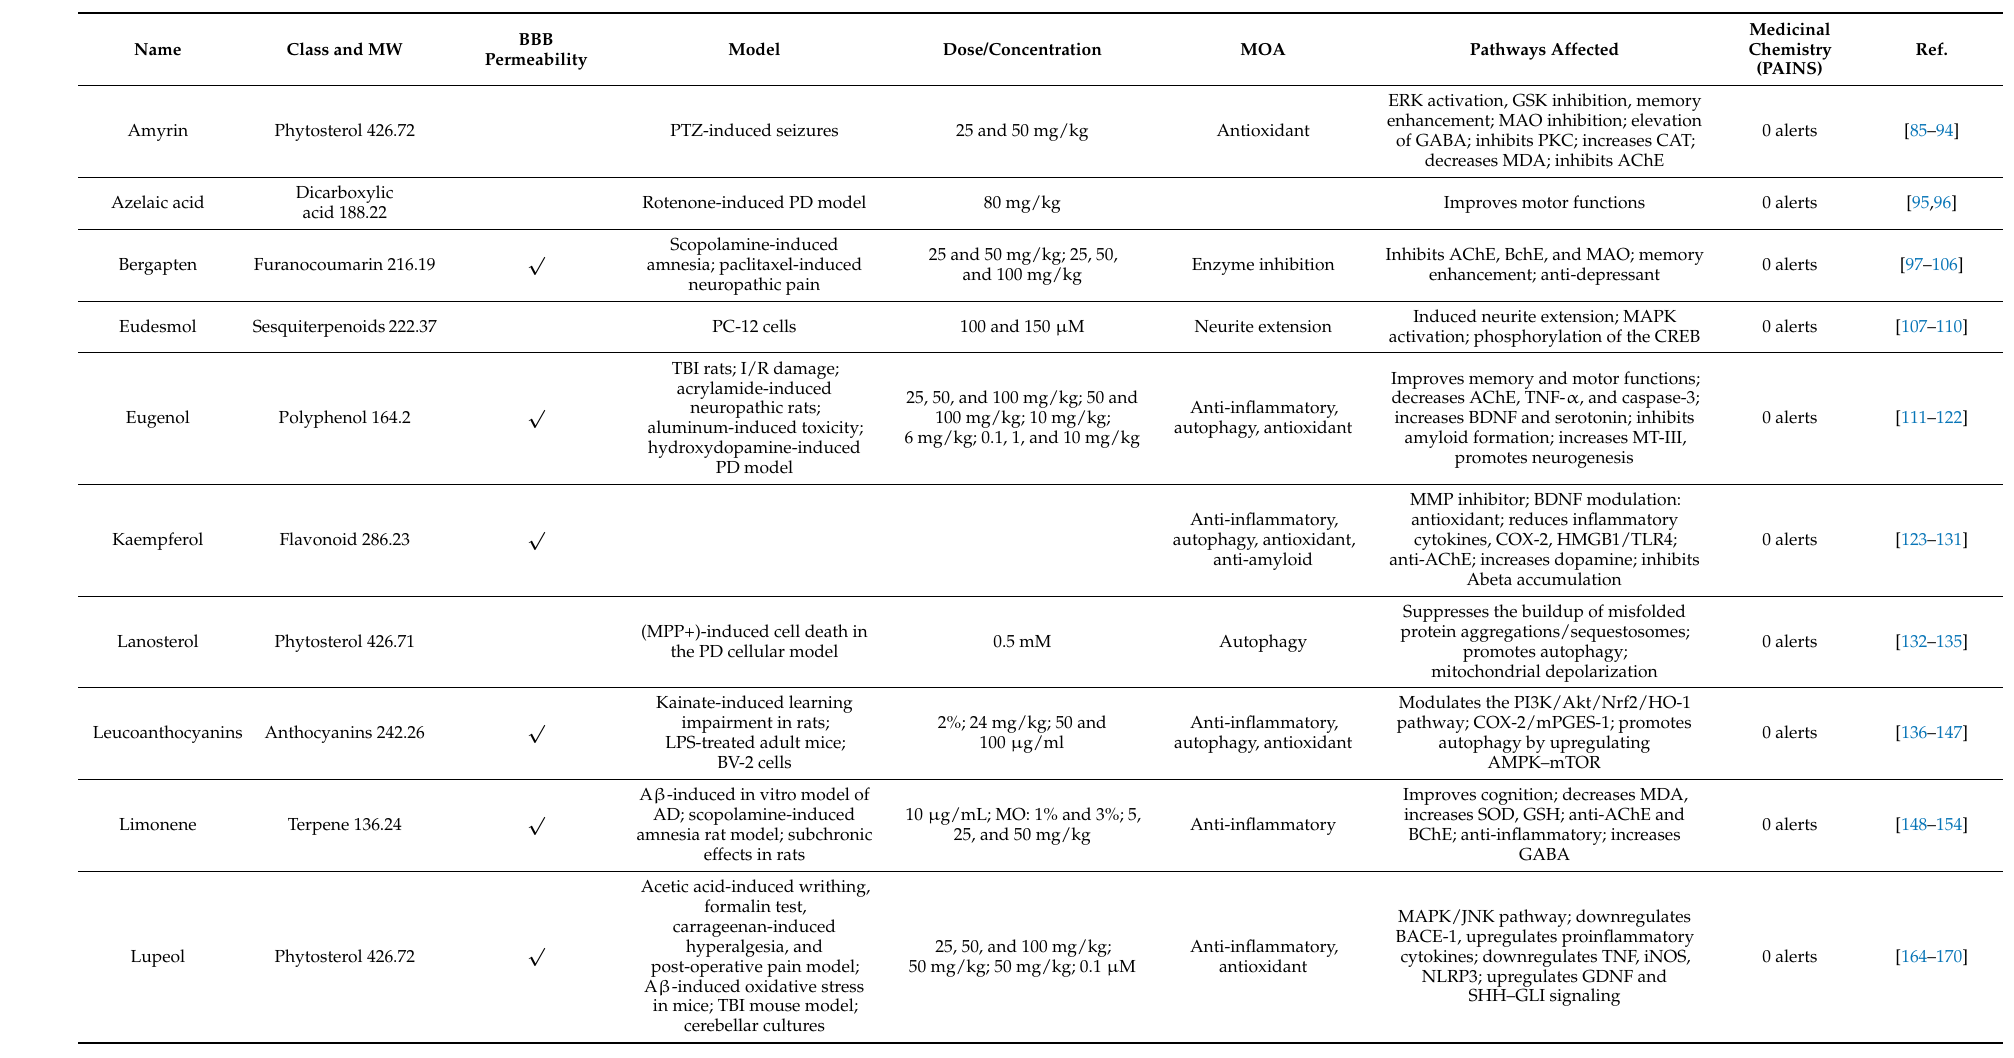
Table 2. Neuroprotective mechanism of some important phytocompounds from sacred Ficus